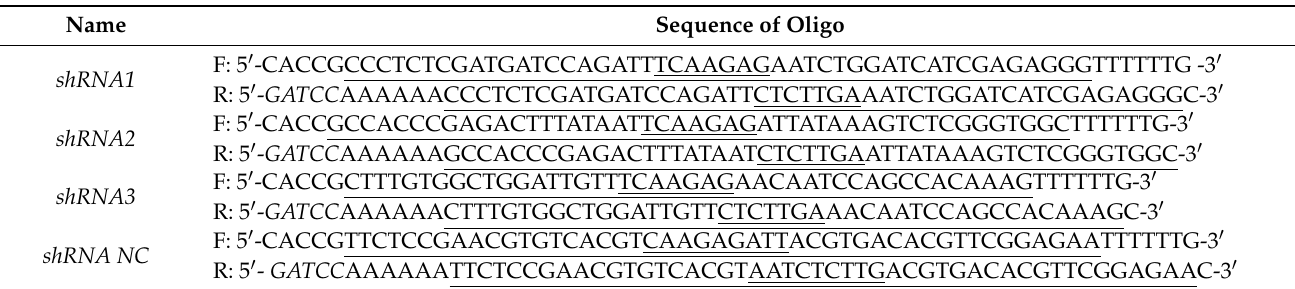
Table 2. The oligomeric single-stranded DNA sequence of